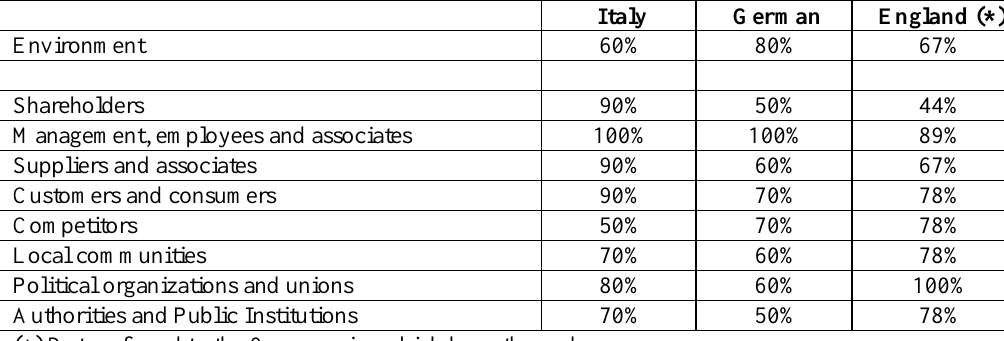
Table 3: Level of Orientation to